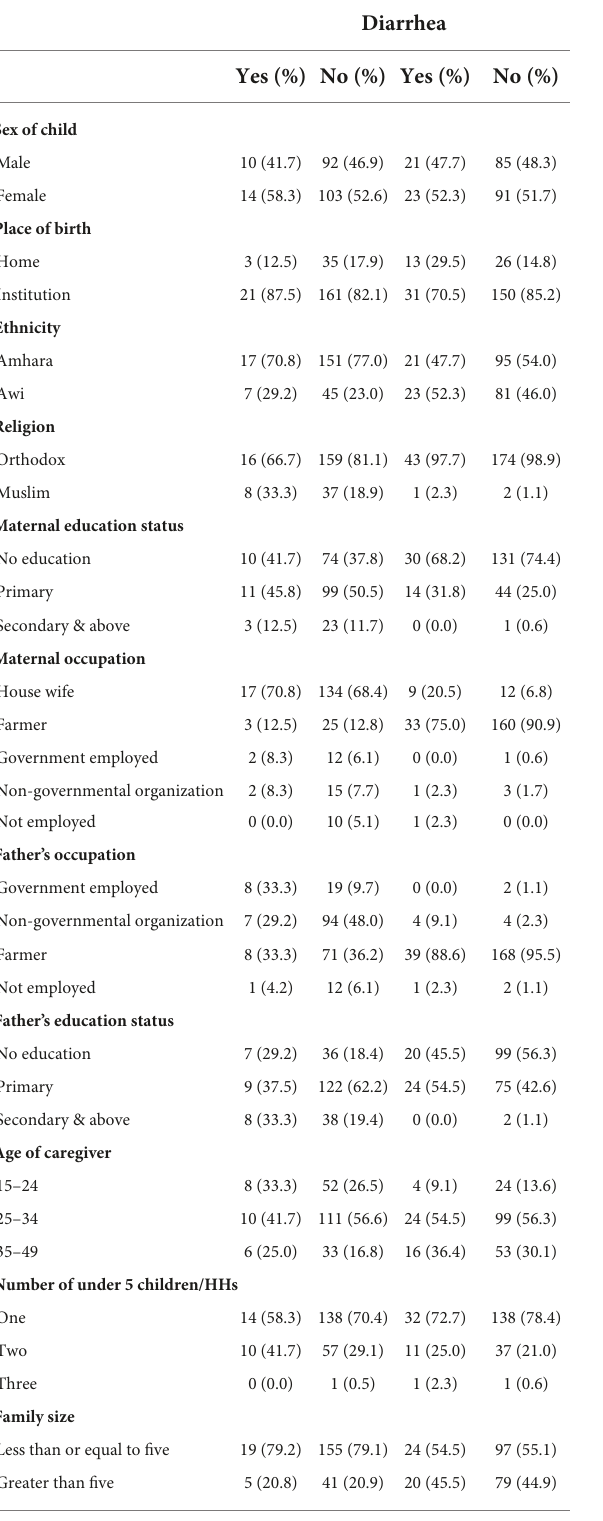
TABLE 1 Socio demographic characteristics of respondents in Jawi district, Awi Zone, southwest Ethiopia, 2019. Variables Model HHs